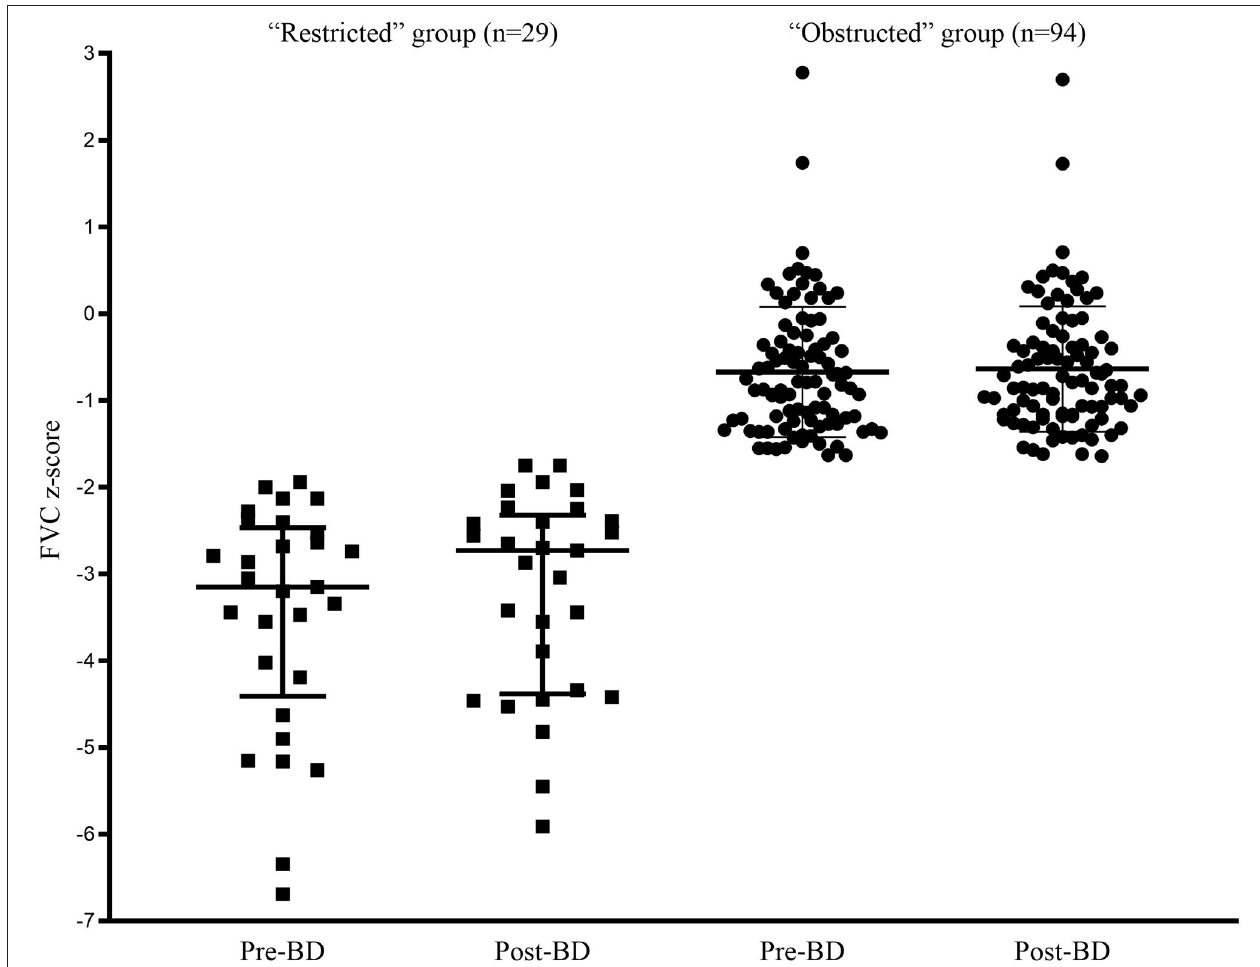
FIGURE 1 | Pre-BD and post-BD FVC in “restricted” and “obstructed” groups.